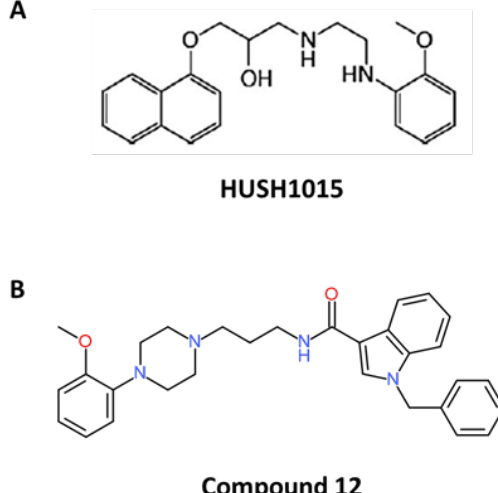
Figure 2. Chemical structures of naftopidil analogues (according to [82,91]). ( A ) Chemical structure of HUHS1015 and ( B ) chemical structure of compound 12.